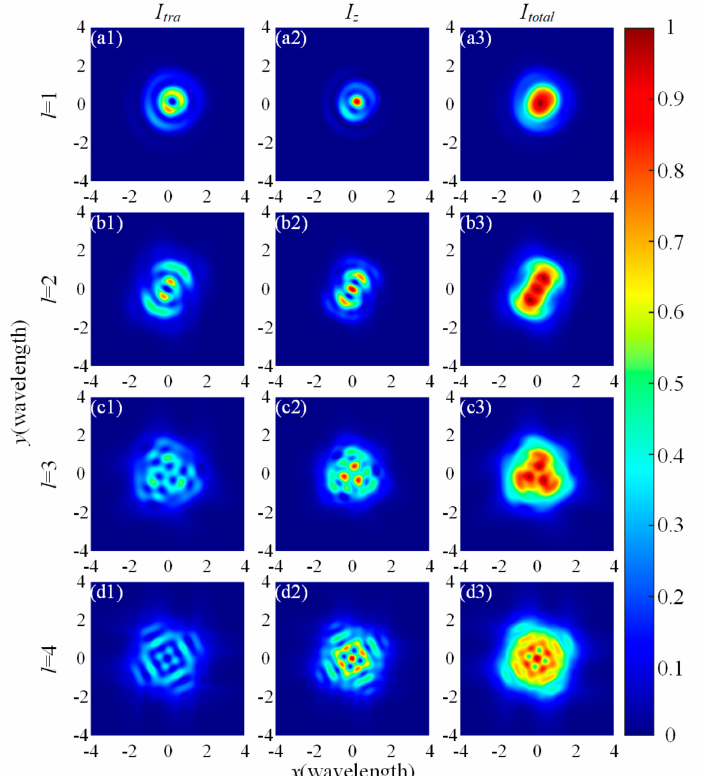
Figure 2. The normalized intensity distribution of each component ( n = 4, p = 1, and p ’ = 1). ( a1 – d1 ) The transverse intensity distribution, ( a2 – d2 ) the longitudinal intensity distribution, and ( a3 – d3 ) the total intensity distribution of the RP-LG-RSPEPV beams with topological charges of